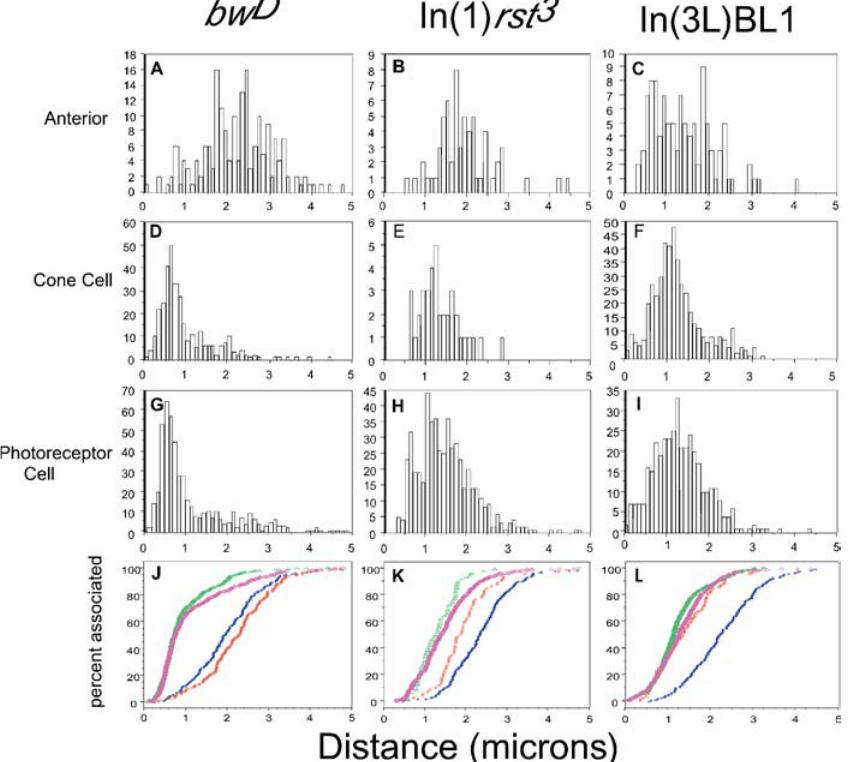
Figure 4. Association Primarily Occurs in Non-Dividing Cells Physical distances in microns between heterochromatic probe signals and P1 probe signals were measured for each line and sorted based upon their position relative to the morphogenic furrow and cell fate. (A–C) Cells anterior to morphogenic furrow. (D–F) Differentiated cone cells behind the morphogenic furrow. (G–I) Differentiated photoreceptor cells behind the morphogenic furrow. (J–L) Percentile plots for histograms in (A–I). Blue, wild-type cells; red, anterior cells; green, cone cells; pink, photoreceptor